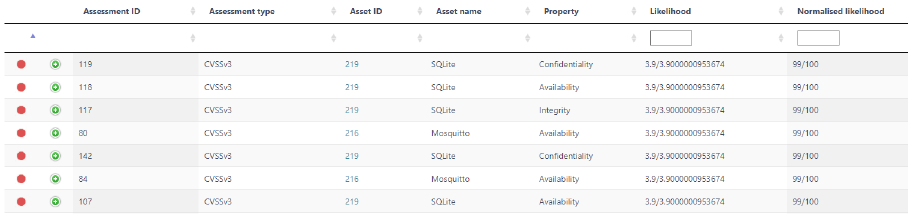
Figure 7. Security